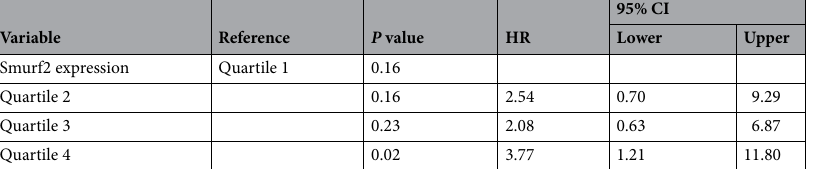
Table 2. Multivariable analysis of disease-free survival in patients with stage III squamous NSCLC. Race, T stage, and surgical margin were included in the multivariable